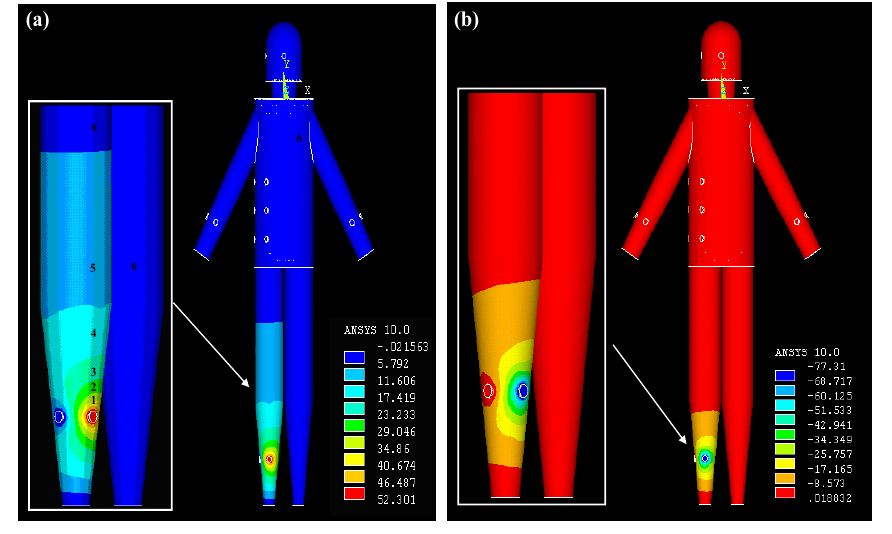
Figure 7. The real part ( a ) and the imaginary part ( b ) of the potential distribution when signal transmits from the